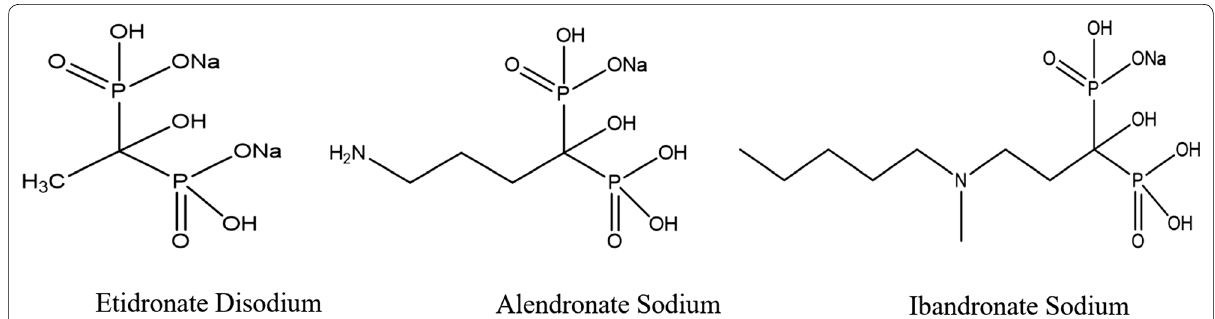
Fig. 2 Molecular structures of studied bisphosphonate drugs. All compounds are presented in anhydrous